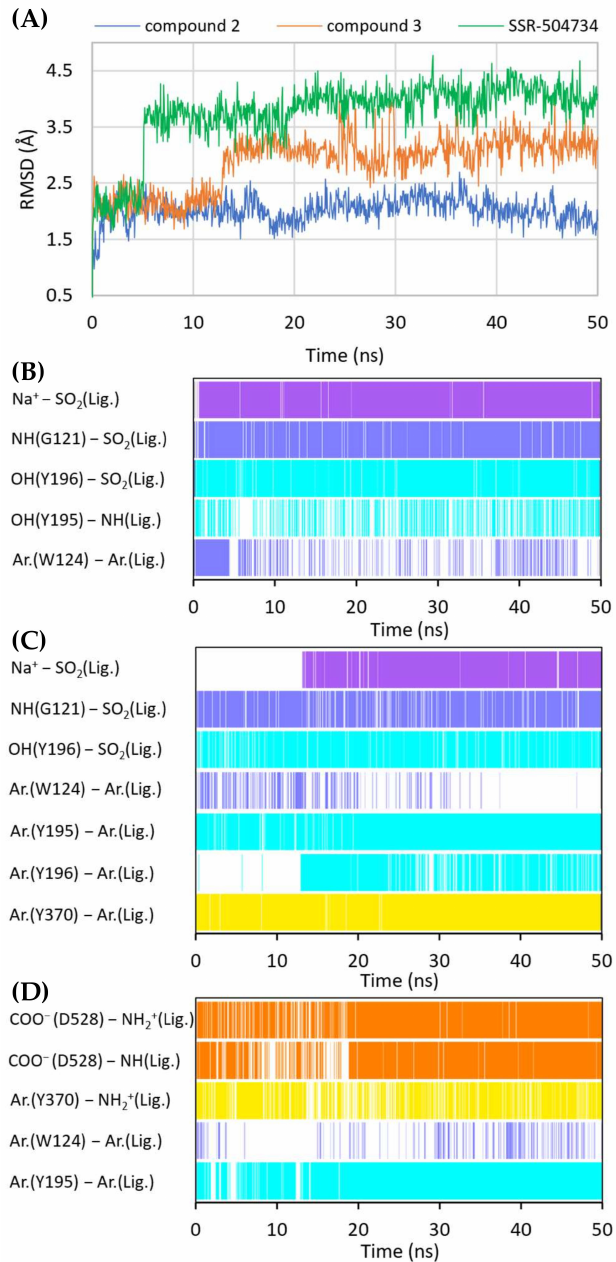
Figure 8. RMSD changes observed for the ligands in a complex with GlyT-1 in an outward-open state in the course of MD simulations ( A ). Stability of the key interactions between the ligand and the transporter for compound 2 ( B ), compound 3 ( C ), and SSR-504734 ( D ). The presence of interactions in a particular MD frame is marked in